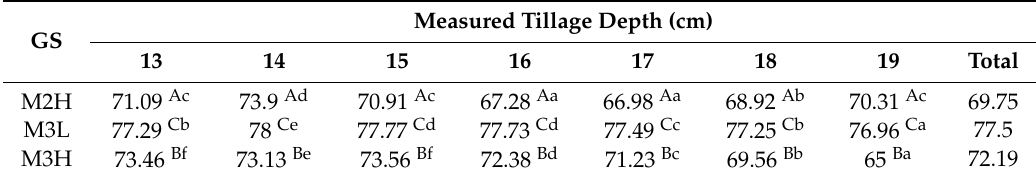
Table 9. Mean engine power (kW) according to the tillage depth and gear selection